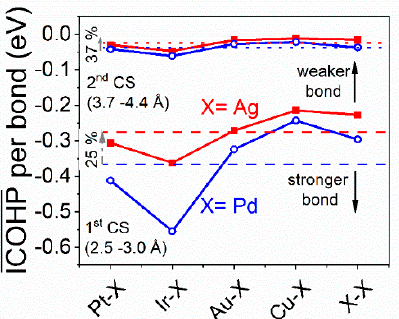
Figure 5. Integrated crystal orbital Hamilton population (ICOHP) per bond for binary combinations of X (X = Ag, Pd) with Au, Cu, Ir, Pt and X itself in a near-equiatomic PtIrCuAuX (X = Ag, Pd) system. CS signifies the coordination shell and the dashed lines depict the average ICOHP per bond across all interactions for the respective systems.